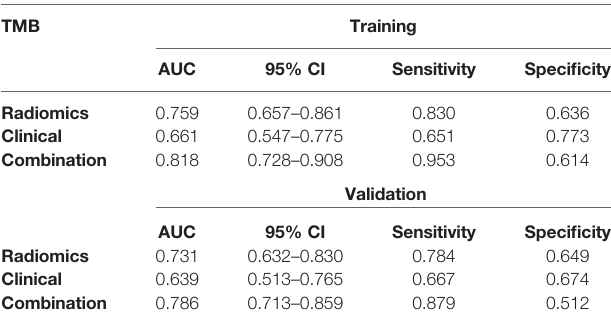
TABLE 6 | The predictive performance of the radiomics model, the clinical model, and the combined model for predicting TMB status in the training and validation